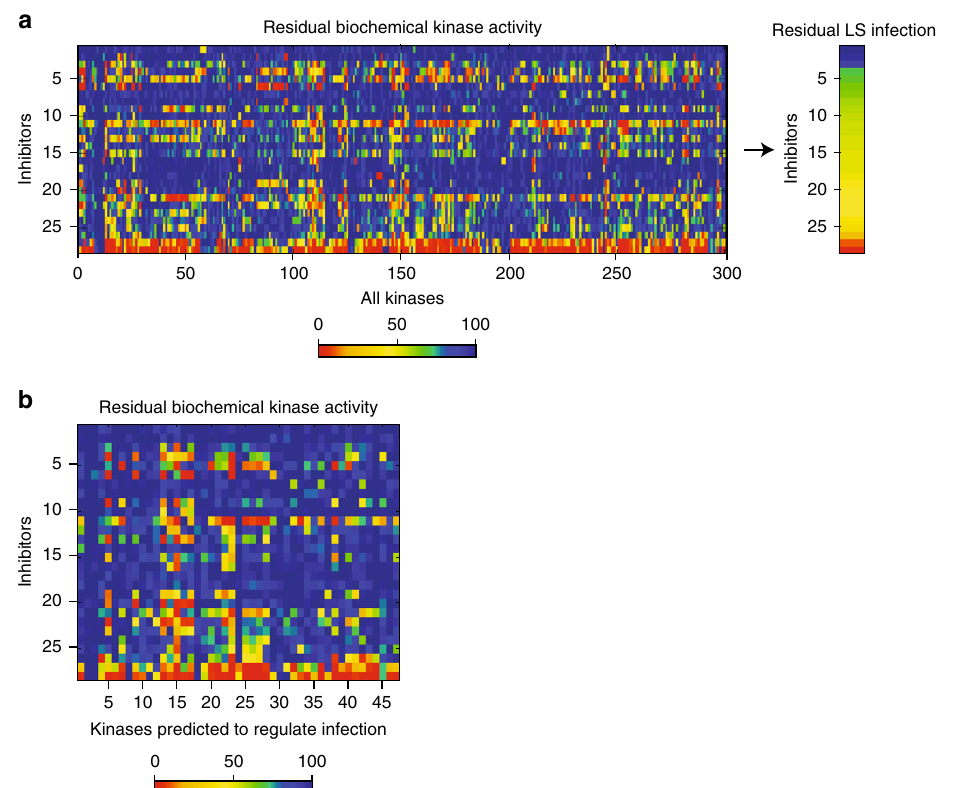
Fig. 2 Kinase pro fi les facilitate predictions of key host kinases for LS infection. a Heat map depicting residual kinase activity for 300 kinases in response to the 28 kinase inhibitors that were used to train an elastic net regression model. Inhibitors are ranked by their capacity to inhibit LS infection 21 . b Heat map depicting residual kinase activity of 47 hit kinases identi fi ed in response to selected panel of kinase inhibitors. Inhibitors are ranked by their capacity to inhibit LS